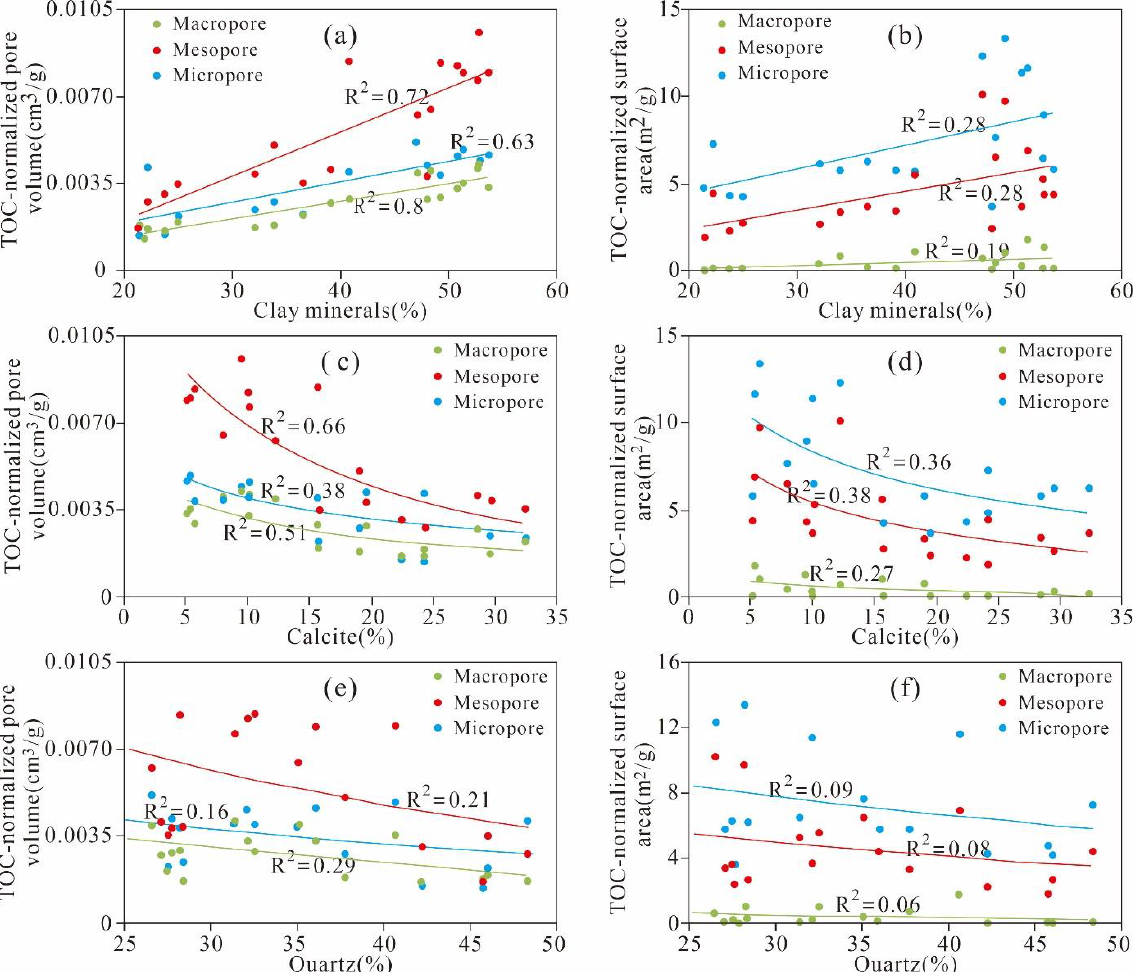
Figure 12. TOC-normalized PVs and SAs of different scales versus the ( a , b ) clay mineral content, ( c , d ) calcite content, and ( e , f ) quartz content.